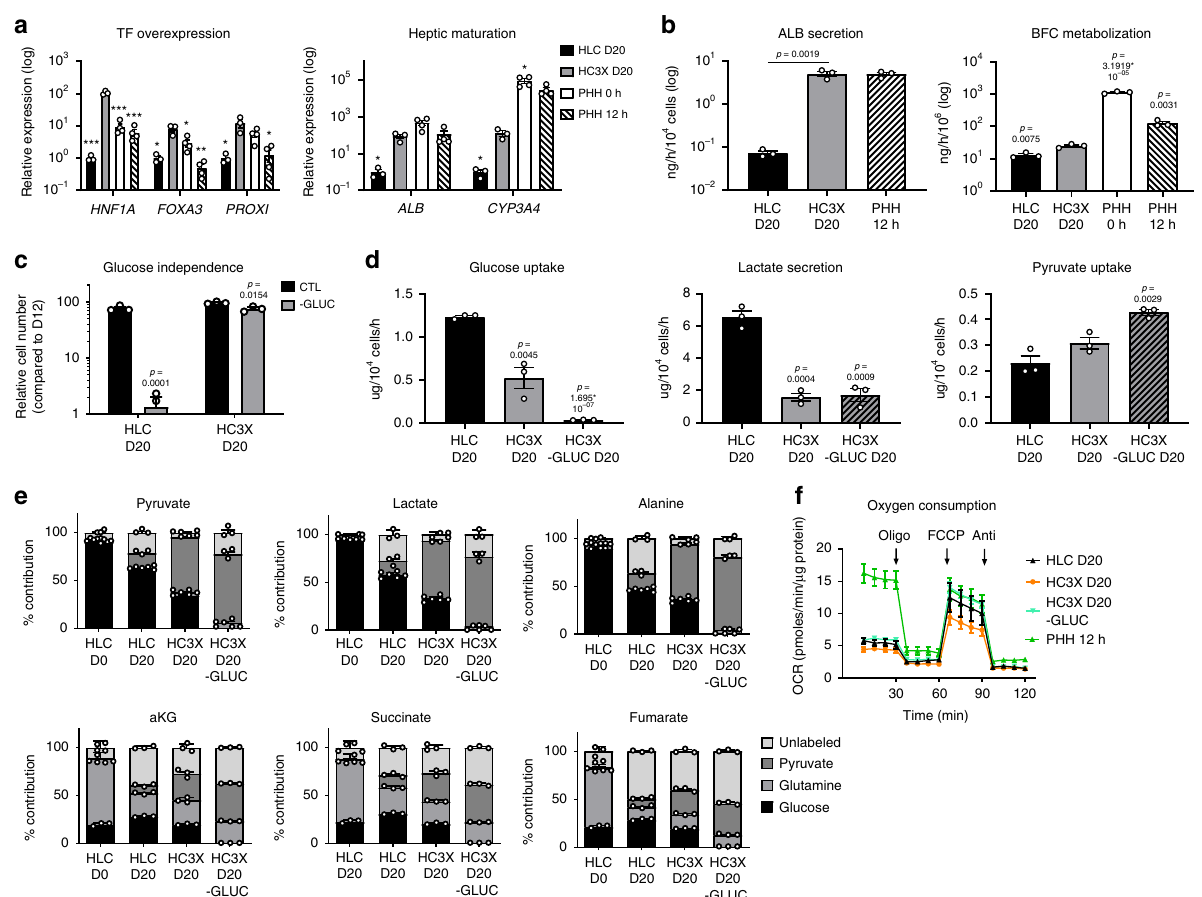
Fig. 2 Overexpression of HNF1A , FOXA3 , and PROX1 induces partial functional and metabolic maturation. a Relative gene expression analysis. N = 3 independent differentiations for HLC and HC3X, N = 4 donors for PHH. Signi fi cance was calculated compared with HC3X D20 by unpaired two-tailed Student ’ s t -test. * p < 0.05, *** p < 0.001. b Functional comparison between HLC D20, HC3X D20, and PHH 12 h. Data for HLC and PHH 12 h are repeated from Fig. 1d. N = 3 independent differentiations for HLC and HC3X; N = 3 donors for plated PHH 12 h. Signi fi cance was calculated compared with HC3X D20 unpaired two-tailed Student ’ s t -test. c Relative cell number (%) comparing CTL media and media without glucose ( − Glucose) for HLC D20 and HC3X D20. N = 3 independent differentiations. Signi fi cance was calculated by comparing differentiation with and without glucose by unpaired two-tailed Student ’ s t -test. d Glucose, lactate, and pyruvate uptake or secretion in HLC D20 and HC3X D20, the latter grown with (HC3X) or without (HC3X-GLUC) glucose. N = 3 independent differentiations; N = 3 donors for PHHs. Signi fi cance was calculated by comparing differentiations with HLC D20 by unpaired two-tailed Student ’ s t -test. e Percentage of 13 C-labeled glucose, glutamine, or pyruvate contribution to pyruvate, lactate, alanine, alpha-ketoglutarate (aKG), succinate, and fumarate. The non-labeled fraction was designated as unlabeled. N = 3 independent differentiations. f Oxygen consumption rates with addition of oligomycin, FCCP, and antimycin for HC3X D20 cultured with glucose (HC3X D20) or without glucose (HC3X D20 – GLUC). Data for HLC D20 and PHH 12 h are repeated from Fig. 1g. N = 6 wells, 5 time point measurements per well. PHH = N = 6 wells for 2 different donors, 5 time point measurements per well. Data in all panels represent mean ± SEM with P -values indicated when signi fi cant. Source data are provided as a Source Data fi